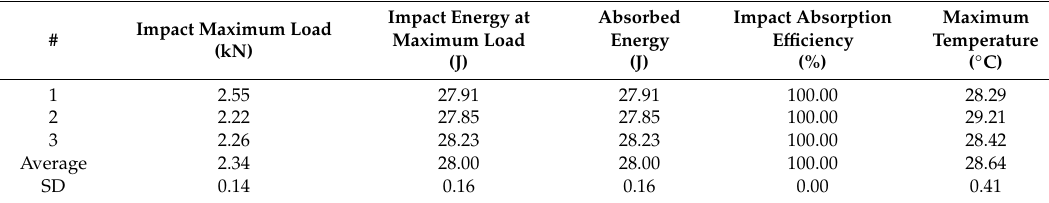
Table 9. Impact test results of Type 5.